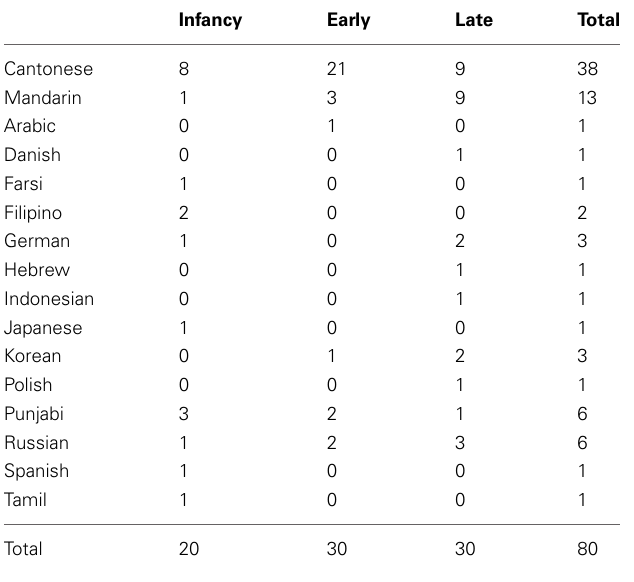
Table 2 | Multilingual participants’ other language data.